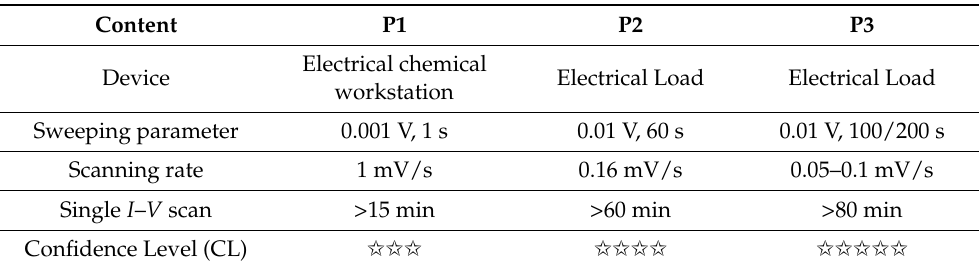
Table 1. A schematic parameter set of the proposed standard procedure of polarization cure measurement.